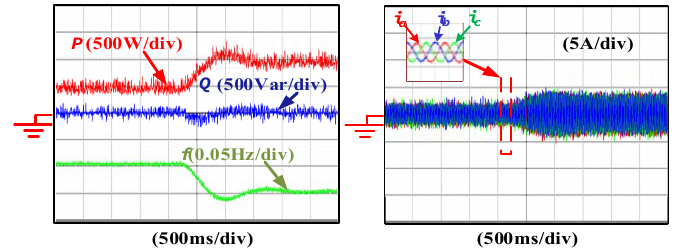
Figure 11. Experimental waveform of power and current when frequency decreases.